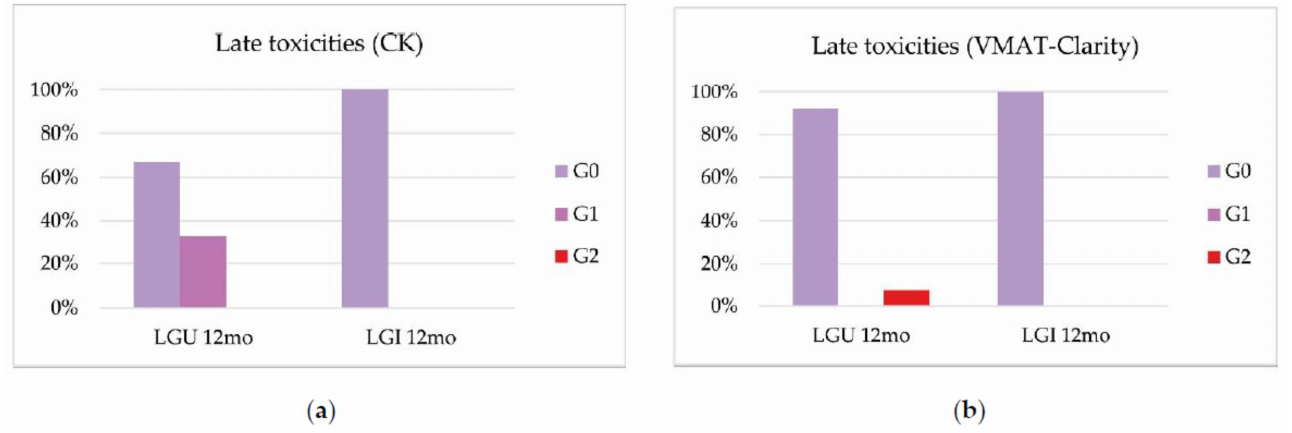
Figure 3. Late genitourinary (LGU) and gastrointestinal (LGI) toxicity in Cyberknife ® group ( a ) and VMAT-Clarity ® group ( b